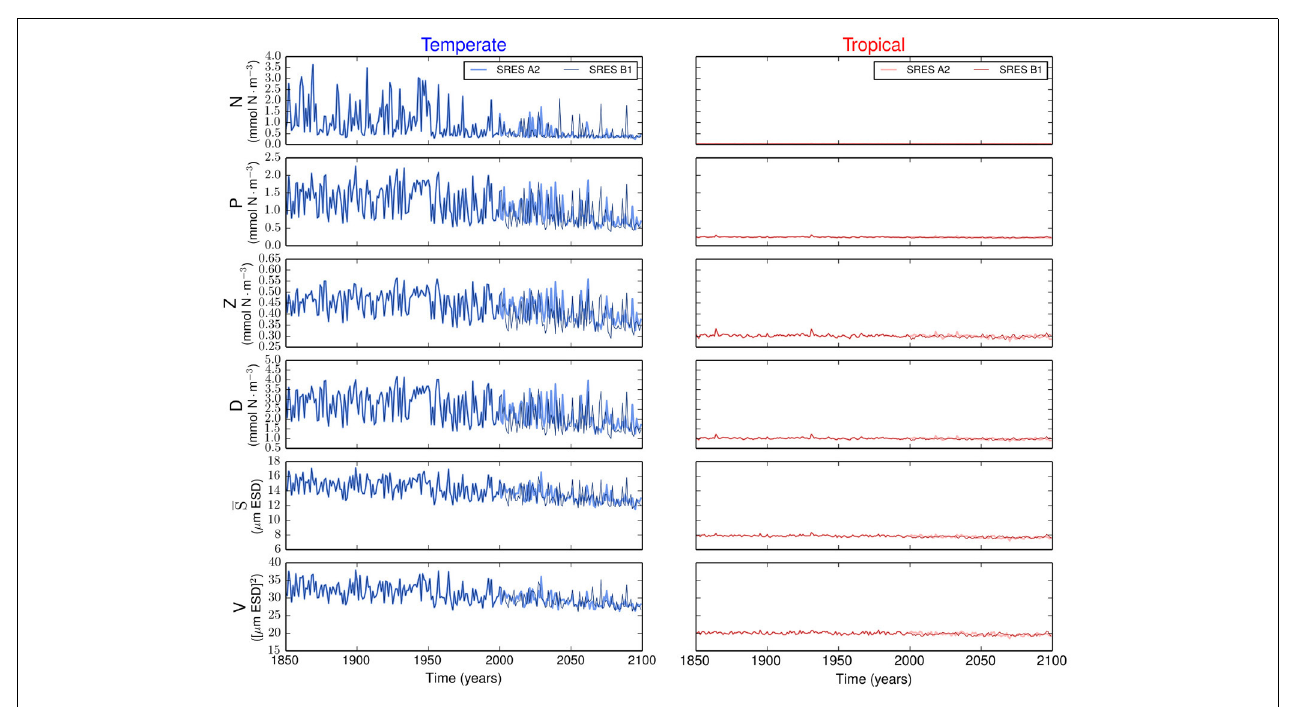
FIGURE 2 | Time series of the state variables for the temperate and tropical regions under the SRES A2 and the SRES B1 emission scenarios. N is the nutrient concentration, P is the phytoplankton